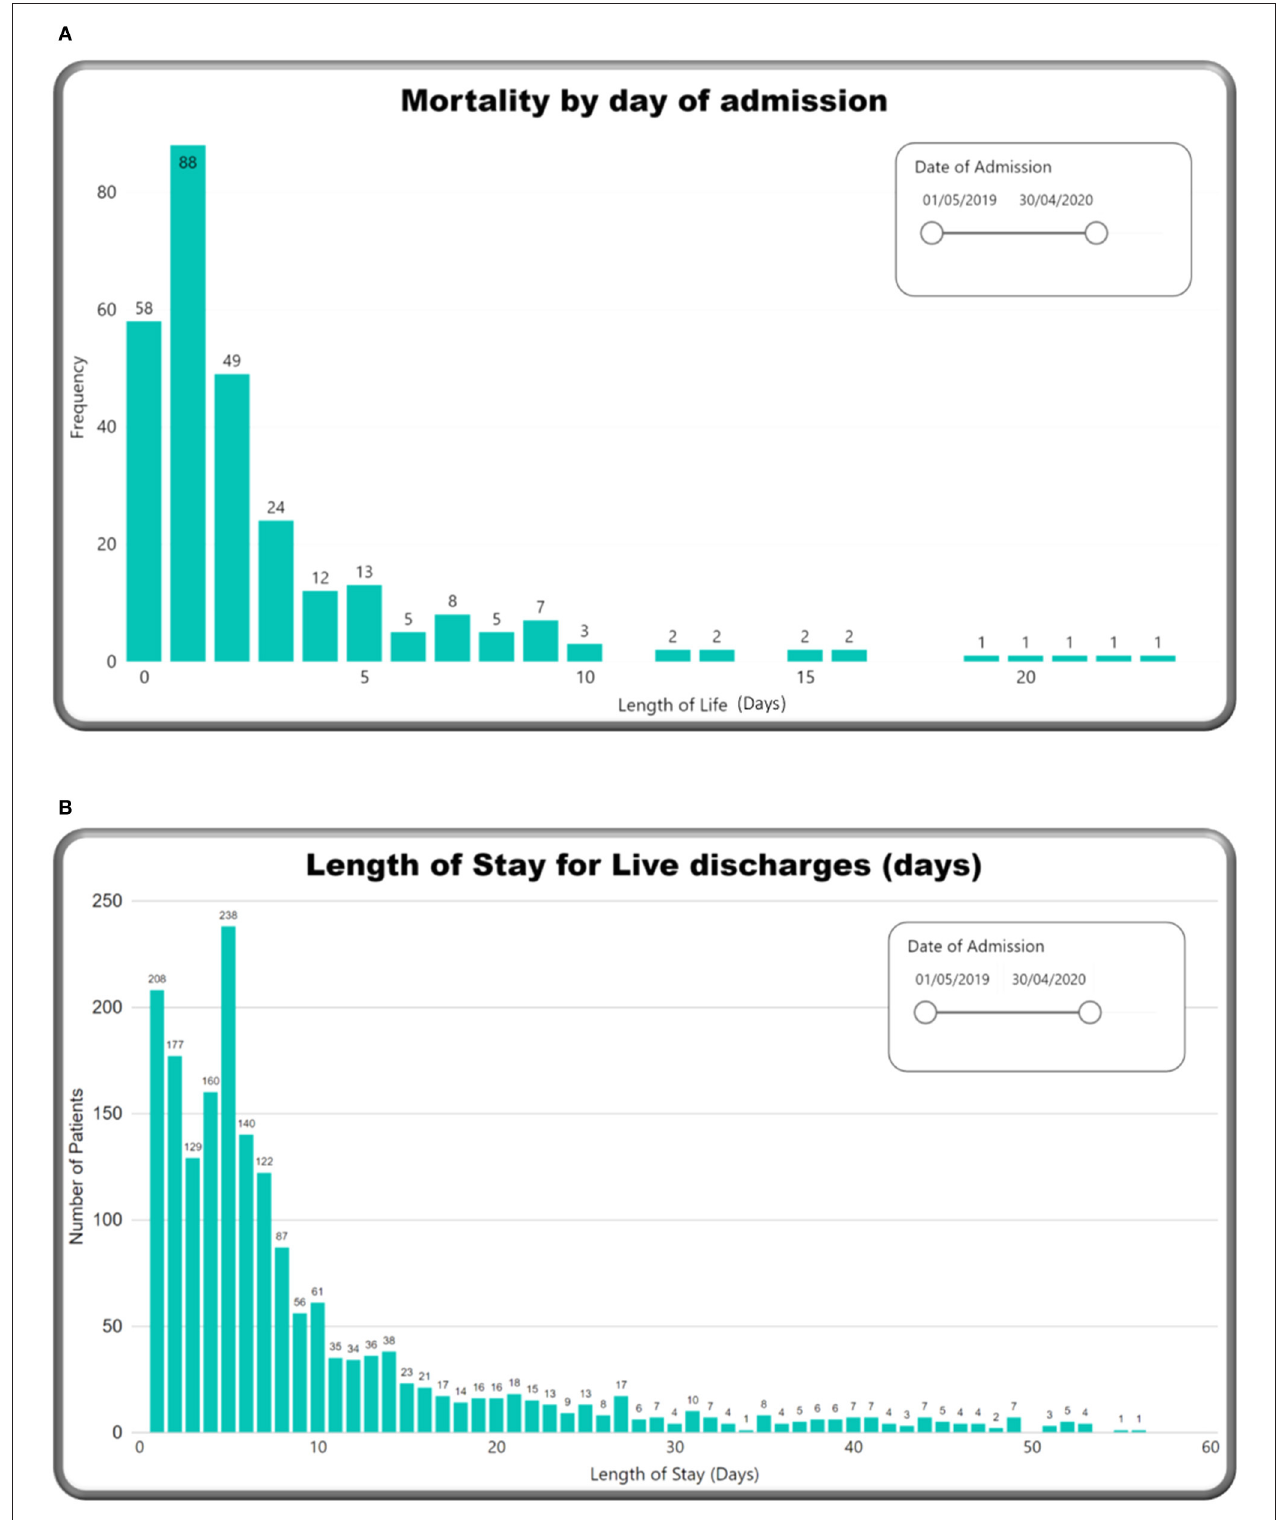
FIGURE 6 | M&M dashboard visuals: (A) Mortality by day of admission, (B) length of stay.